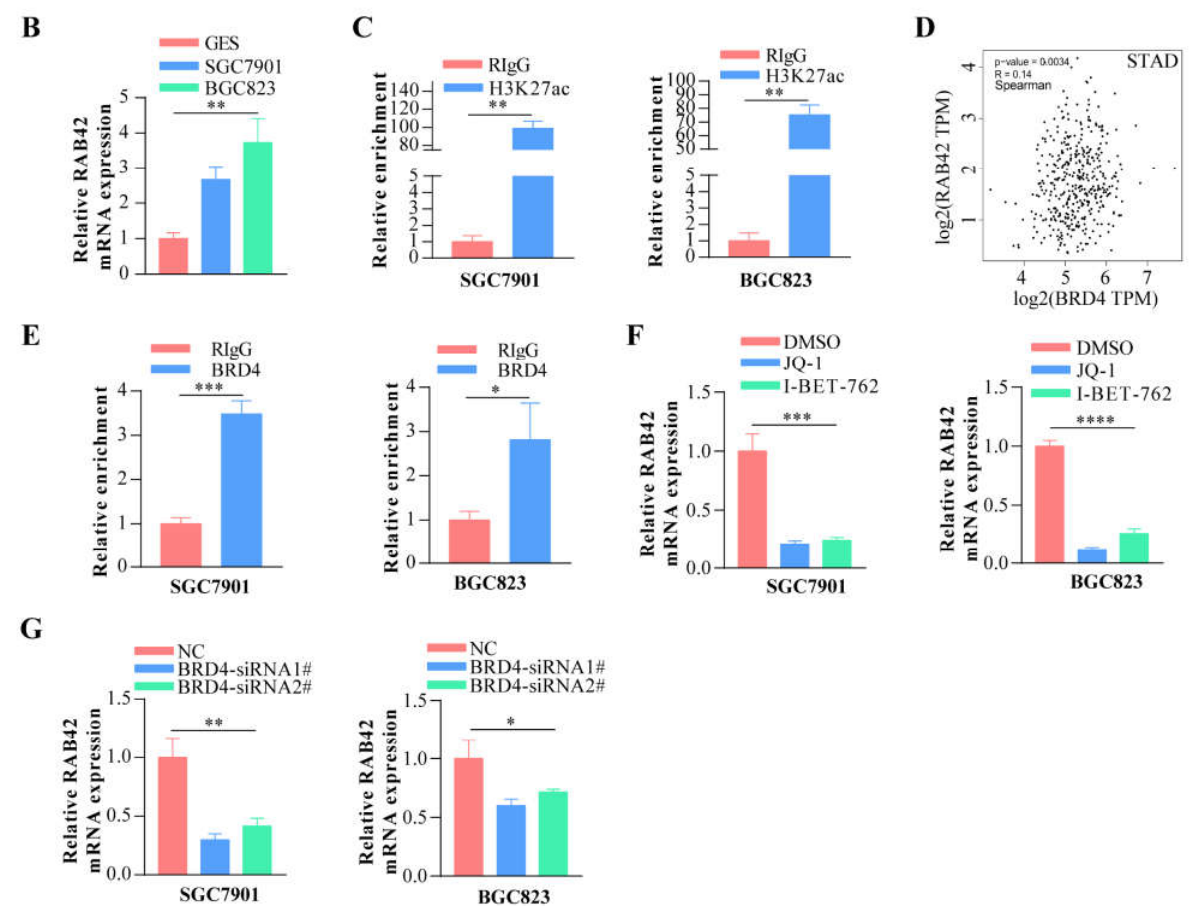
Figure 11. The effect of super enhancer on RAB42 expression. ( A ) ChIP-seq profiles of H3K27ac signal in RAB42 gene loci in different tumor cells. ( B ) The relative RAB42 expression was deter-mined in gastric cancer cells by qPCR. ( C ) The relative enrichment levels of H3K27ac to RAB42 gene loci by ChIP-qPCR. ( D ) Correlation between BRD4 and RAB42 expression in STAD using the GEPIA database. ( E ) The relative enrichment levels of BRD4 to RAB42 gene loci by ChIP-qPCR. ( F ) The relative RAB42 expression after the treatment with JQ1 (1uM) and I-BET-762 (2uM) by qPCR. ( G ) The relative RAB42 expression after BRD4 knockdown by qPCR. * p < 0.05, ** p < 0.01, *** p < 0.001, and **** p < 0.0001.